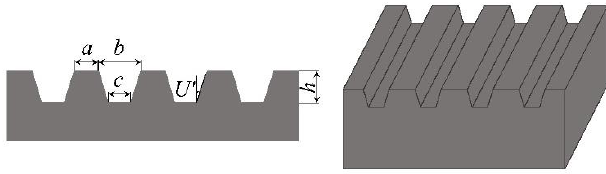
Figure 2. Trapezoidal groove structure.